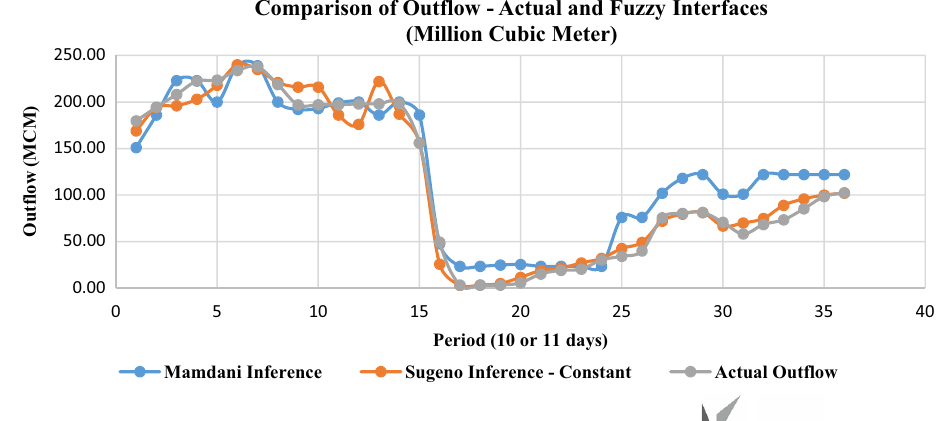
Fig. 7 Outflow comparison— actual and fuzzy